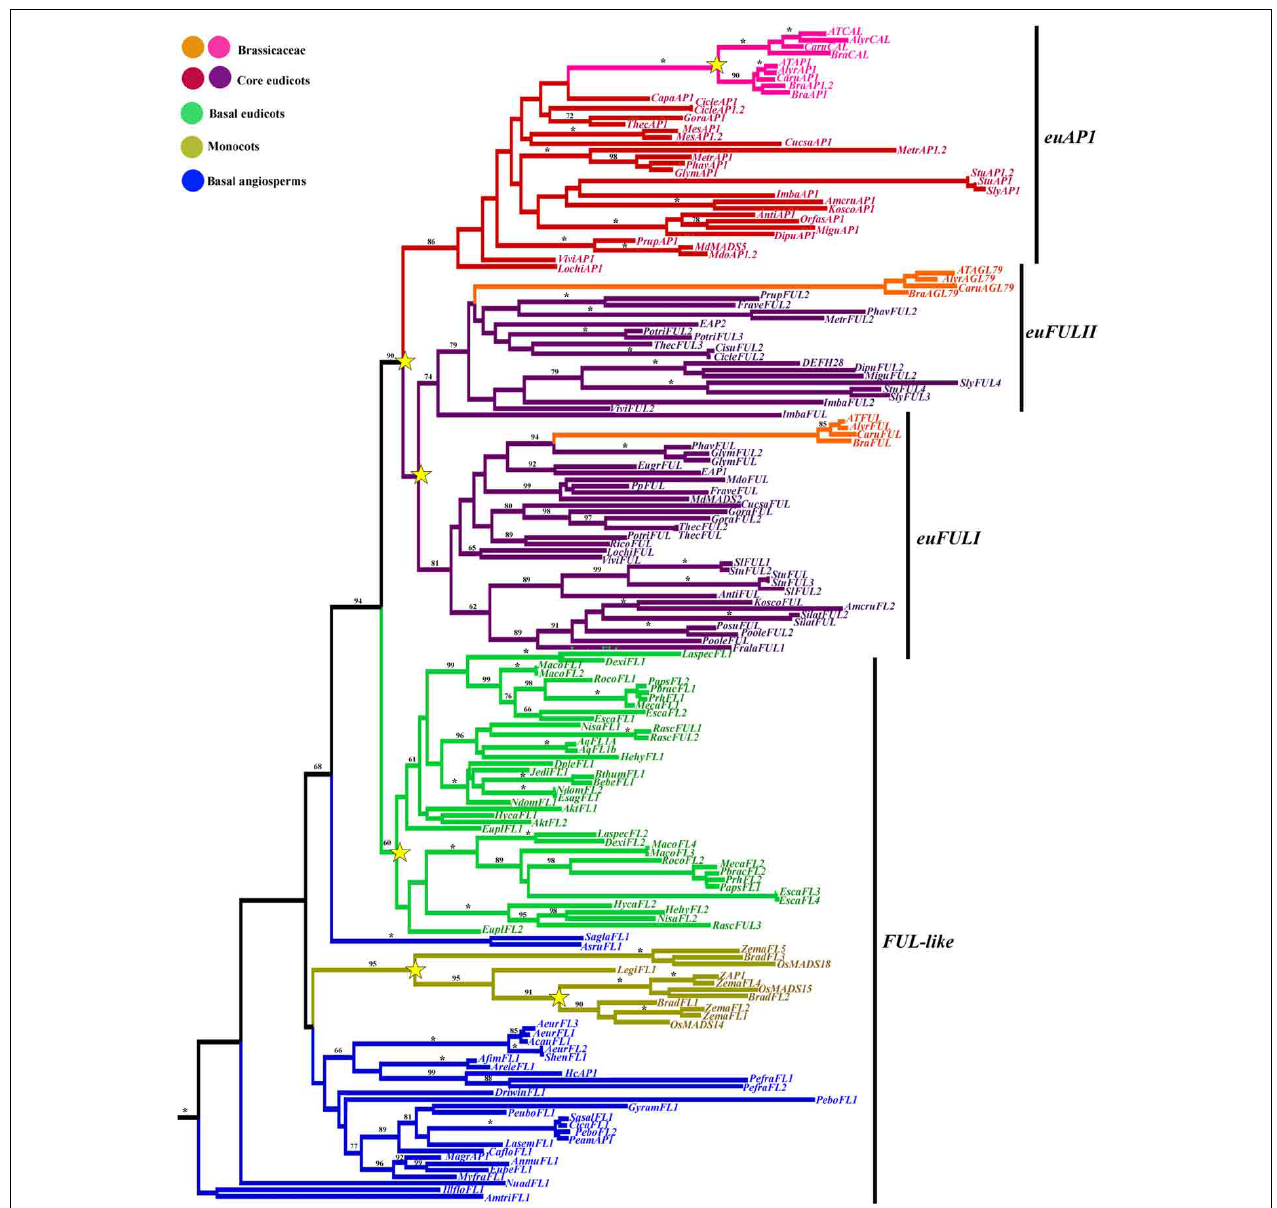
FIGURE 3 | ML tree of APETALA1/FRUITFULL genes in angiosperms showing five duplication events (yellow stars). Two duplications in Poaceae, resulting in three distinct monocot FUL-like clades; one duplication in basal eudicots resulting in two Ranunculiid FUL-like clades; two